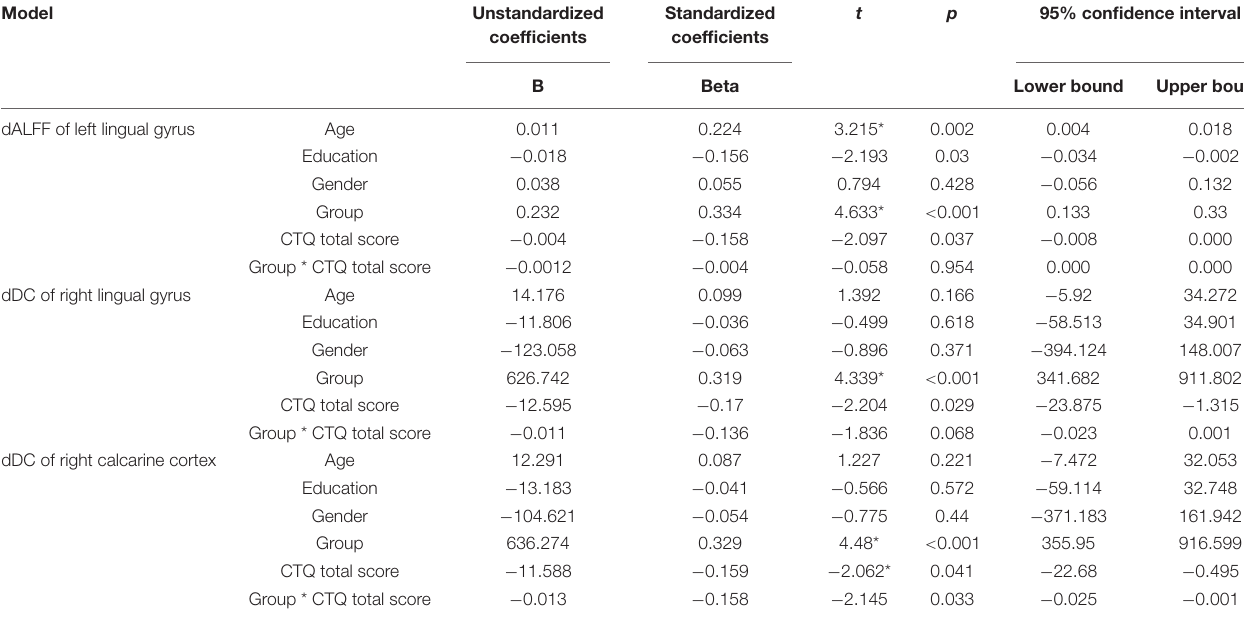
TABLE 8 | Multiple linear regressions analyses between childhood trauma history and dynamic